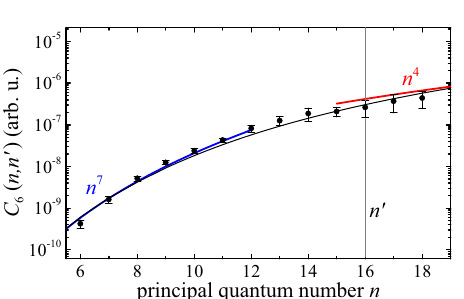
Fig. 1 Two-color spectroscopy of excitonic Rydberg series. a A weak pump laser (blue) excites excitons in the 16 p state which interact via the interaction potential V ( r ) with np excitons that are excited by a weak probe laser (red) at a certain detuning Δ . E gap = 2.17208 eV indicates the band gap. b These inter-state interactions have a profound effect on the probe-exciton dynamics and tend to block their optical generation within pump-probe distances below the blockade radius r bl , as indicated by the violet spheres. c In our experiment, we modulate the pump beam by an optical chopper and use a lock-in ampli fi er to lock the recording of the transmitted probe photons (sig.) to the modulation frequency (ref.). In this way, the output signal of the photodiode (PD) that collects the probe photons is directly proportional to the pump-induced differential probe transmission Δ I . Examples of the recorded spectra are shown in d , which display a series of clear resonances for probe excitons with principal quantum numbers from n = 6 to n = 20. The increasing signal strength with pump power, P , provides indication for the presence of interactions between pump and probe excitons. A common mean fi eld treatment of such interactions is shown in panel e for three increasing interaction strengths. Here, the red line denotes the weakest interaction strength, while the blue line corresponds to the largest interaction strength. However, it fails to reproduce the universal maximum and the isosbestic point observed at fi xed laser detunings Δ max and Δ 0 , respectively, in the experiment, as indicated in f for the n = 11 resonance. On the other hand, these features are well explained by a theory that accounts for strong exciton correlations and excitation-blockade effects, as shown in g , where again, the red line denotes the weakest and the blue line the largest interaction strength. In e – g , the detuning is normalized to the linewidth γ of the resonance. The underlying spatial correlation function, g (2) ( r ) between pump and probe excitons, shown in h , displays an extended exciton blockade for distances below the blockade radius r bl , which is on the order of several μ m in our experiments.